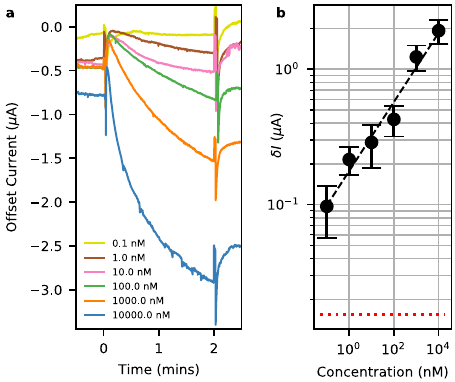
Fig. 4 Detection of MBP-CoV-2NP. a Offset photocurrent at fi xed angle as a function of time. The sensor is initially covered with a buffer solution. At time = 0, the buffer solution is removed and replaced with solutions containing different concentrations of antigen (MBP-CoV-2NP). At time = 2 min the antigen solution is removed and replaced with buffer solution. b Change of photocurrent after 1 min as a function of antigen concentration. Symbols and error bars are the mean and SD of four different sensors. The dotted red line is the noise fl oor of the sensor as de fi ned by the standard deviation of the current during the initial buffer solution stage (time = − 0.5 to 0 min). The dashed black line is a best- fi t guide to the eye. Source data are provided as a Source Data fi